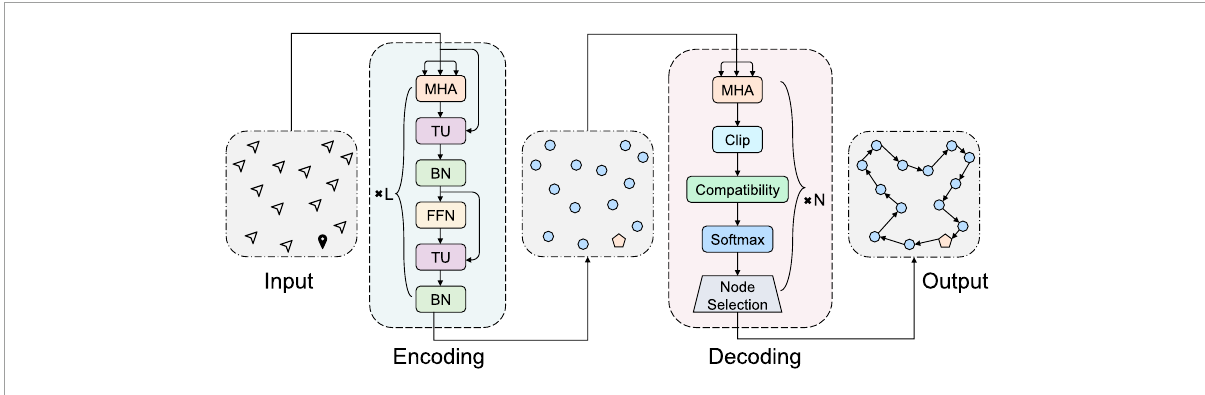
FIGURE 1 Overall framework of our proposed approach. The square pentagon represents the depot and the circle represents the non-depot node to be traversed. MHA, TU, BN, and FFN are short for the multi-head attention, threshold unit, batch normalization, and feed-forward network, which will be detailed in Sections 3.3 , 3.4